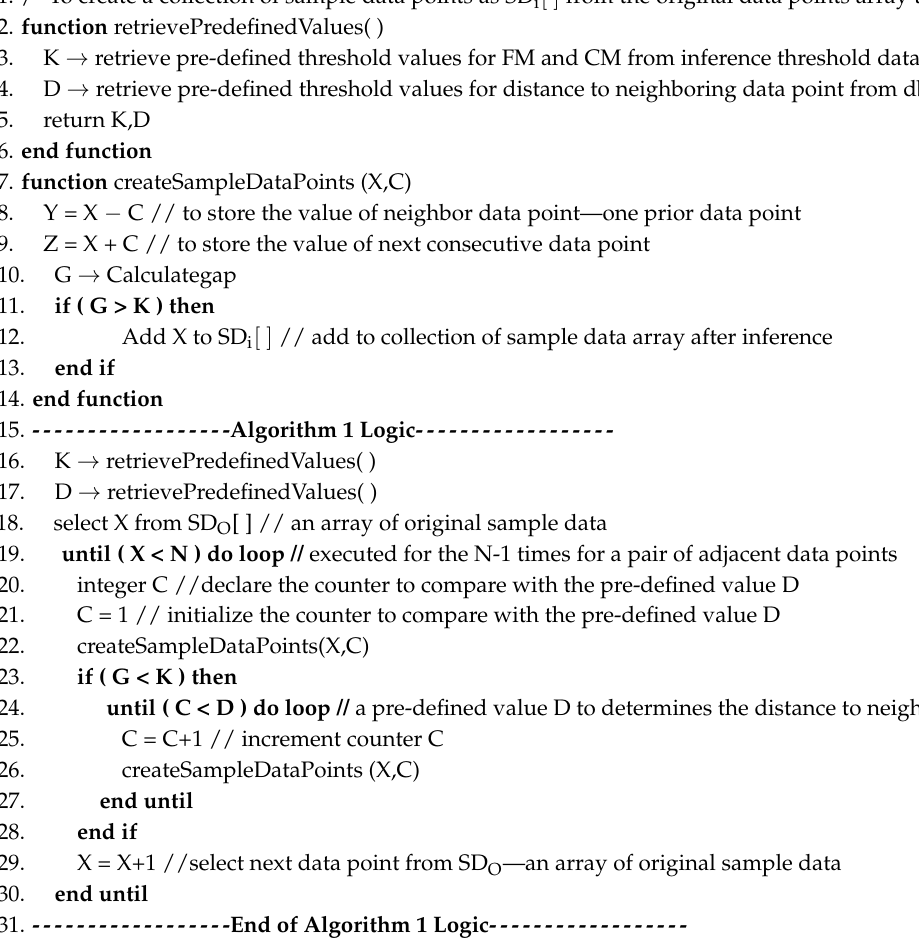
Algorithm 1. Creation of sample data